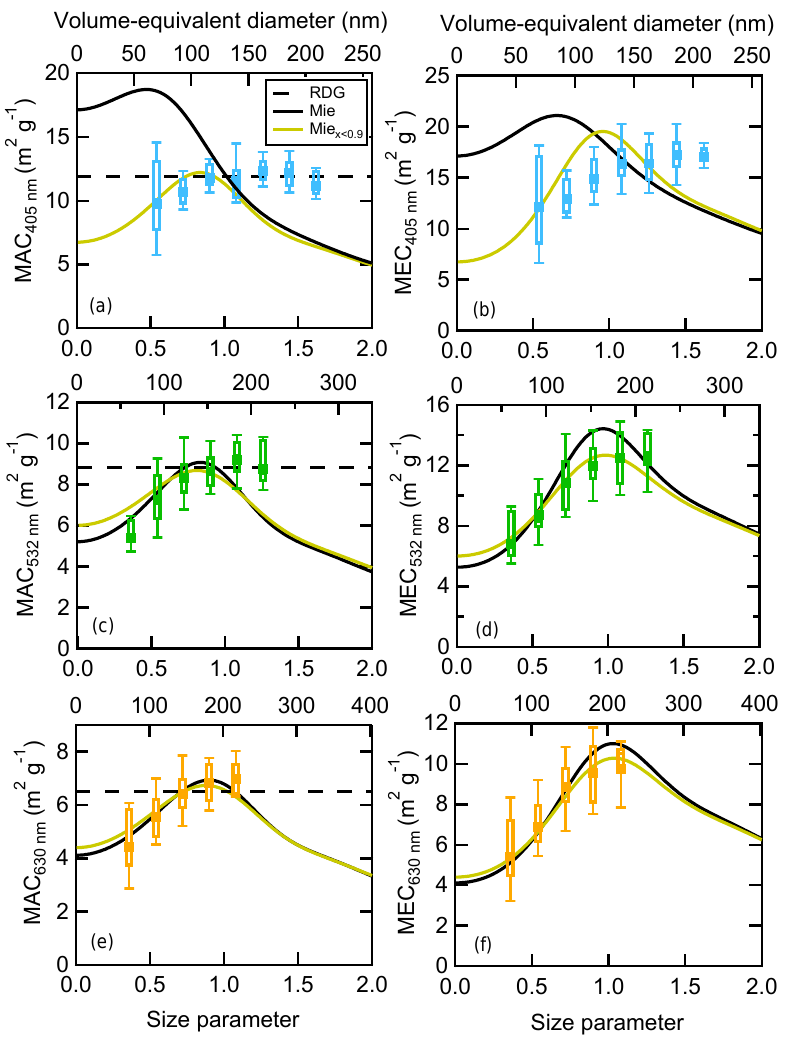
Figure 3. Box plots of MACs and MECs as a function of size parameter, with (cid:49)x = 0 . 18. The volume-equivalent diameters are provided at the top of the plots for reference. Also shown are Mie theory curves for all particles (black solid lines), Mie theory curves for x < 0 . 90 (gold line), and RDG curves (dashed line) calculated from the RI values in Table 1. RI fitting was performed using only the absorption measurements. Panels (a) and (b) are λ = 405nm data from the UCD CRD-PAS, (c) and (d) are λ = 532nm data from the UCD CRD-PAS, and (e) and (f) are λ = 630nm data from the CAPS PM SSA . The poor match between the calculated Mie theory curves at λ = 405nm reflects the difficulties in fitting spherical particle Mie theory to the observed σ abs,405nm over the entire size range. Although the same particle sizes were sampled over all wavelengths, the size parameters sampled at each wavelength are different. Therefore, there are different numbers of boxes for each wavelength. Note that this figure is directly related to Fig. 2, the difference being that the y axis values in Fig. 2 (cross sections) have been divided by the per-particle mass to give the MAC or MEC. Points in each bin range from N = 10 at x 1 . 62 to N = 81 at x 1 . 26 for λ = 405nm, N = 5 at x 0 . 36 to N = 82 at x 1 . 08 at λ = 532nm, and N = 8 at x 1 . 08 to N = 67 at x 0 . 9 at λ =